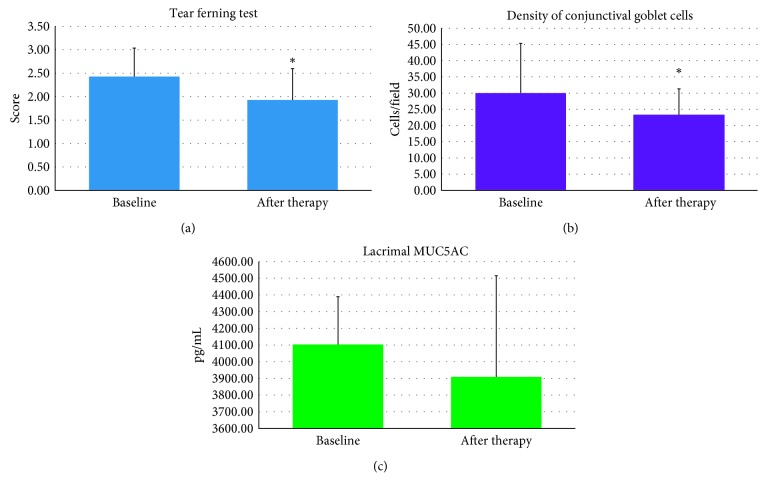
Some signs of pathology improvement 3 months after the start of CY (cyclosporine) therapy, such as TFT (tear ferning test), baseline 2.43 (±0.80 SD) score, and posttherapy 1.93 (±0.67) score (p=0.044) (a); density of conjunctival goblet cells, baseline 30 (±20 SD) cells/field, and posttherapy 23 (±8 SD) cells/field (p=0.044) (b). There are no changes in the MUC5AC levels before (4,103.33 ± 286.35 SD pg/ml) and after therapy (3,909.18 ± 606.01 SD pg/ml) (c), even because a 3-month treatment period is too short to evaluate the possible functional improvement of the conjunctiva in patients with chronic VKC (vernal keratoconjunctivitis).